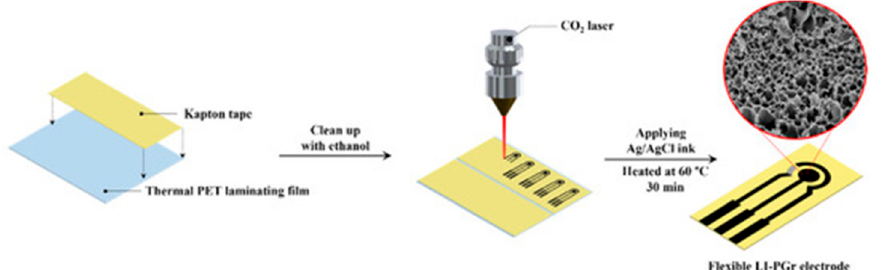
Figure 6. Schematic representation of the fabrication of laser-induced porous graphene electrode [52]. Reused from MDPI under a Creative Common CC BY license.